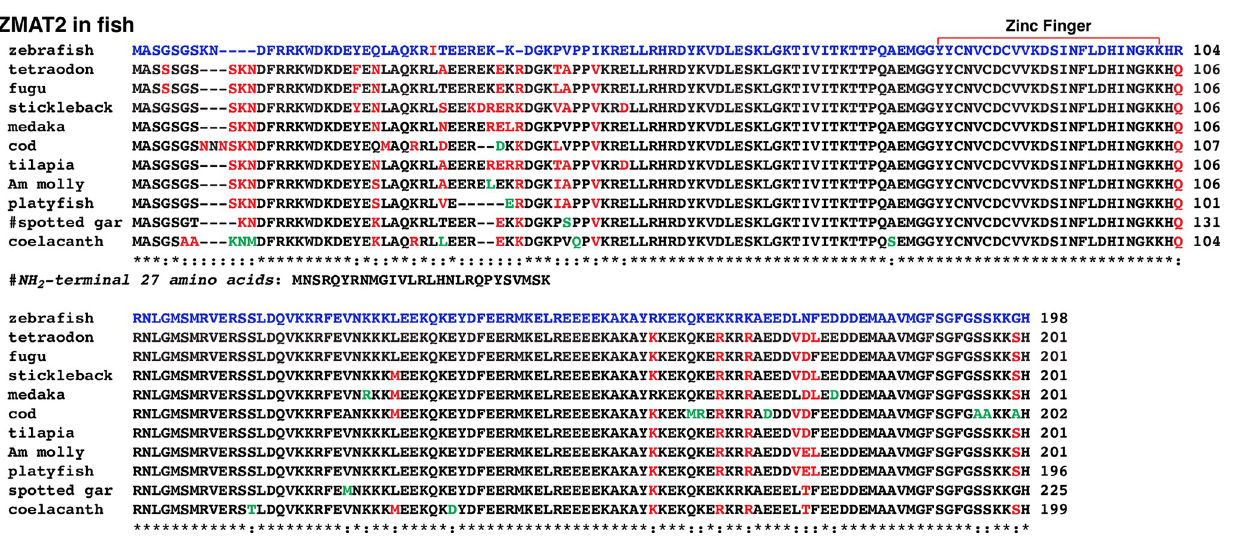
Fig 8. Fish ZMAT2 proteins. Alignments of amino acid sequences of ZMAT2 proteins from different fish are shown in single letter code. Identities and differences among proteins are indicated, with identities labeled by asterisks and differences by colons. Dashes indicating no residue have been placed to maximize alignments. Red and green text also depict differences, with amino acids marked in green indicating a unique change seen in just a single species. The zinc finger region has been labeled. As indicated by the #, spotted gar ZMAT2 has an additional 27 amino acids at its NH 2 -terminus, as shown below. See Table 8 for additional information.